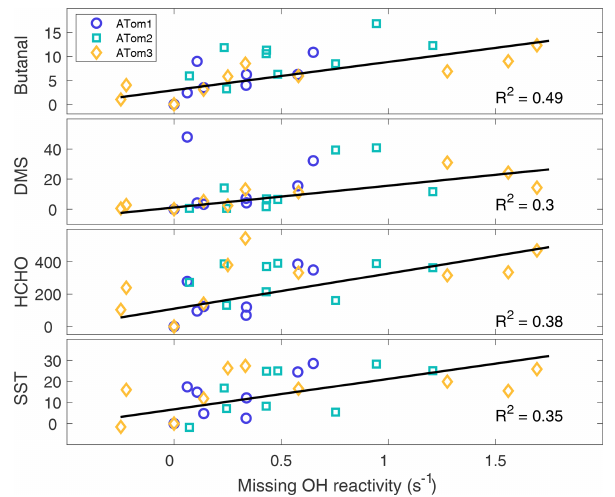
Figure 10. Missing OH reactivity against HCHO for per-dip val- ues in the MBL over the Northern Hemisphere Pacific Ocean. The ATom linear fit (black line) is shown with values for ATom1 (cir- cles), ATom2 (squares), and ATom3 (diamonds). The ATom linear fit is compared to the linear fit for missing OH reactivity values of Mao et al. (2009) (red line) and to this linear fit with an offset correction (red dashed line; see text). Uncertainty bars are the ab- solute uncertainty (95% confidence) of the missing OH reactivity. The statistical uncertainty in the slope and intercept of the linear fit are given in the equation on the